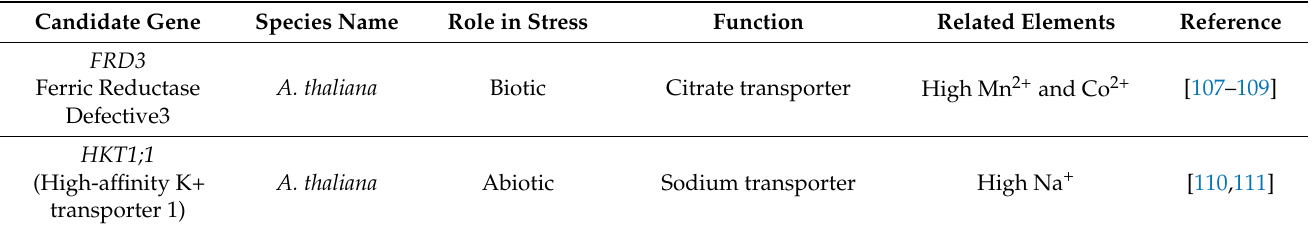
Table 2. List of genes identified in plants through high-throughput ionomics